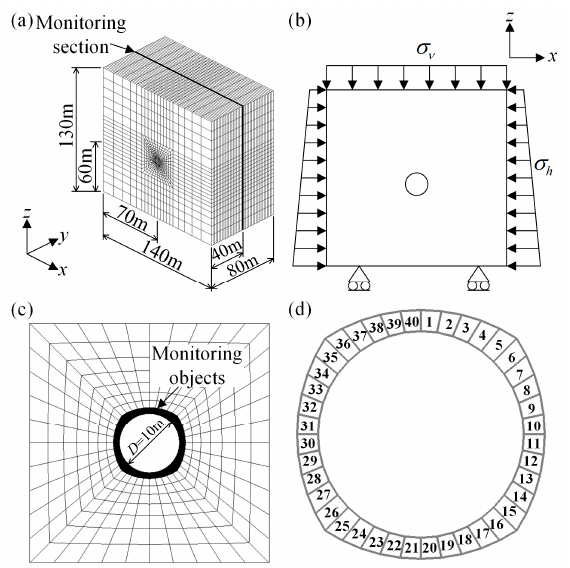
Figure 6. Computational model: ( a ) the extent of model, ( b ) boundary conditions, ( c ) the details of the monitoring section, ( d ) the reference number of the monitoring object.